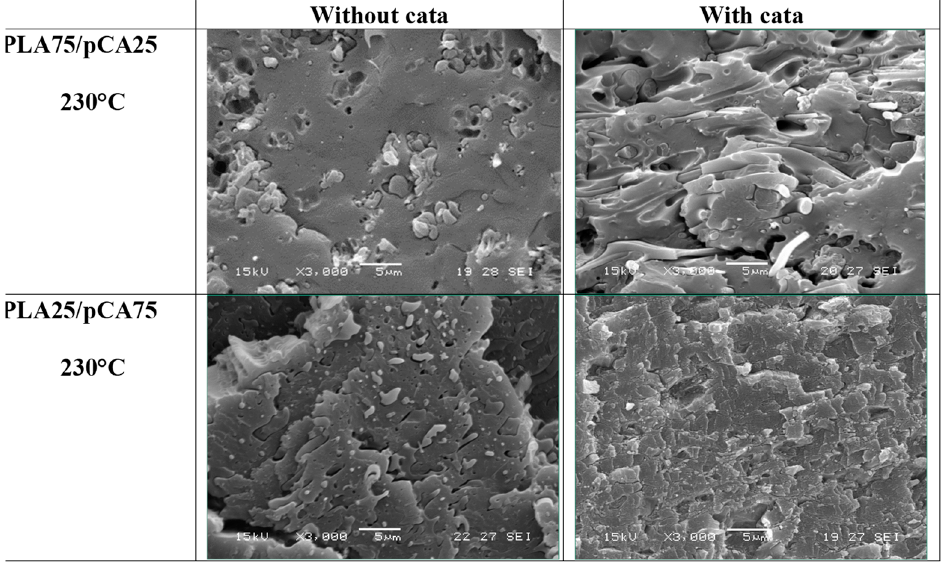
Figure 12. Scanning electron micrographs related to the PLA/pCA blends prepared at 230 °C with or without TBATPB